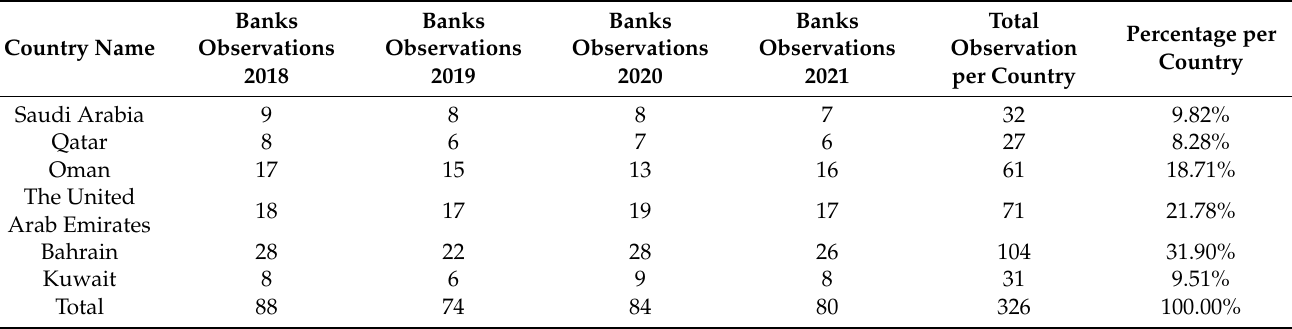
Table 2. Description of the